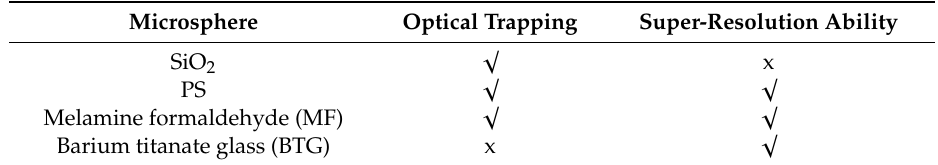
Table 1. Optical trapping performances and super-resolution ability of four microspheres in water.